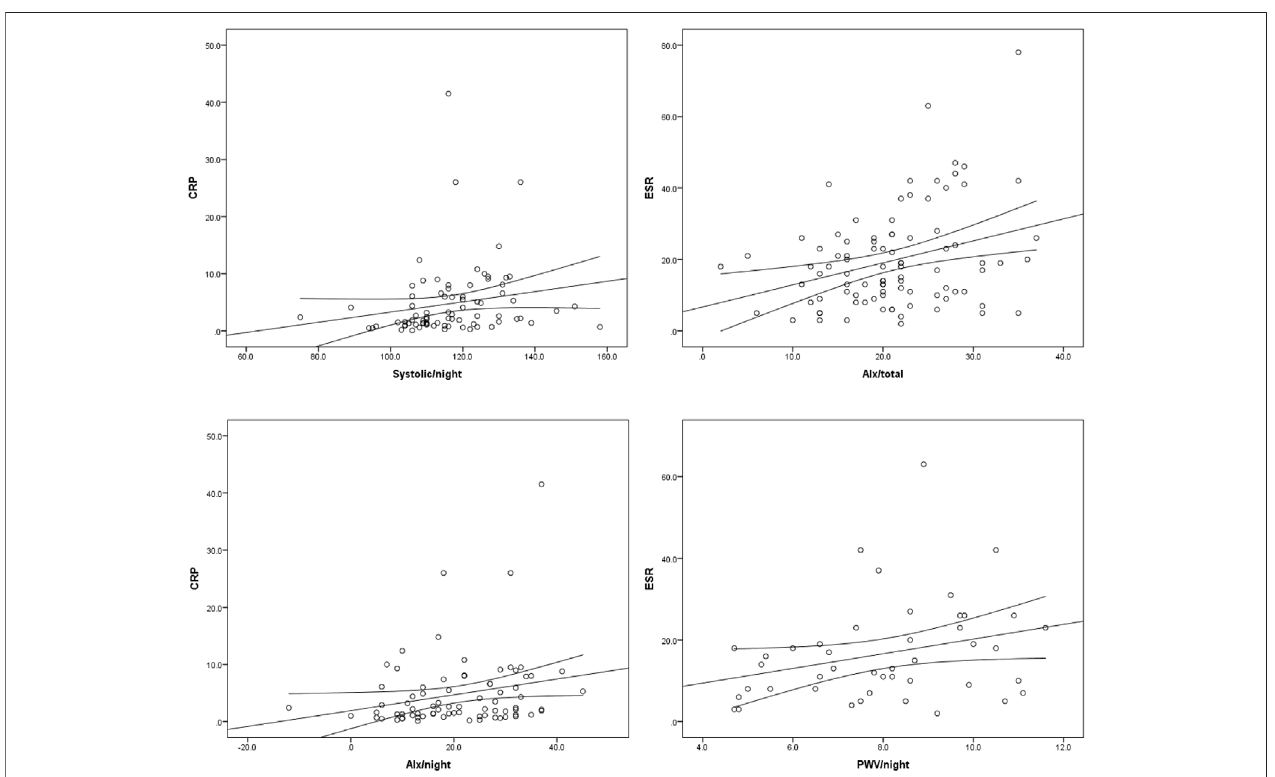
FIGURE 3 | Correlation between CRP, ESR and cardiovascular